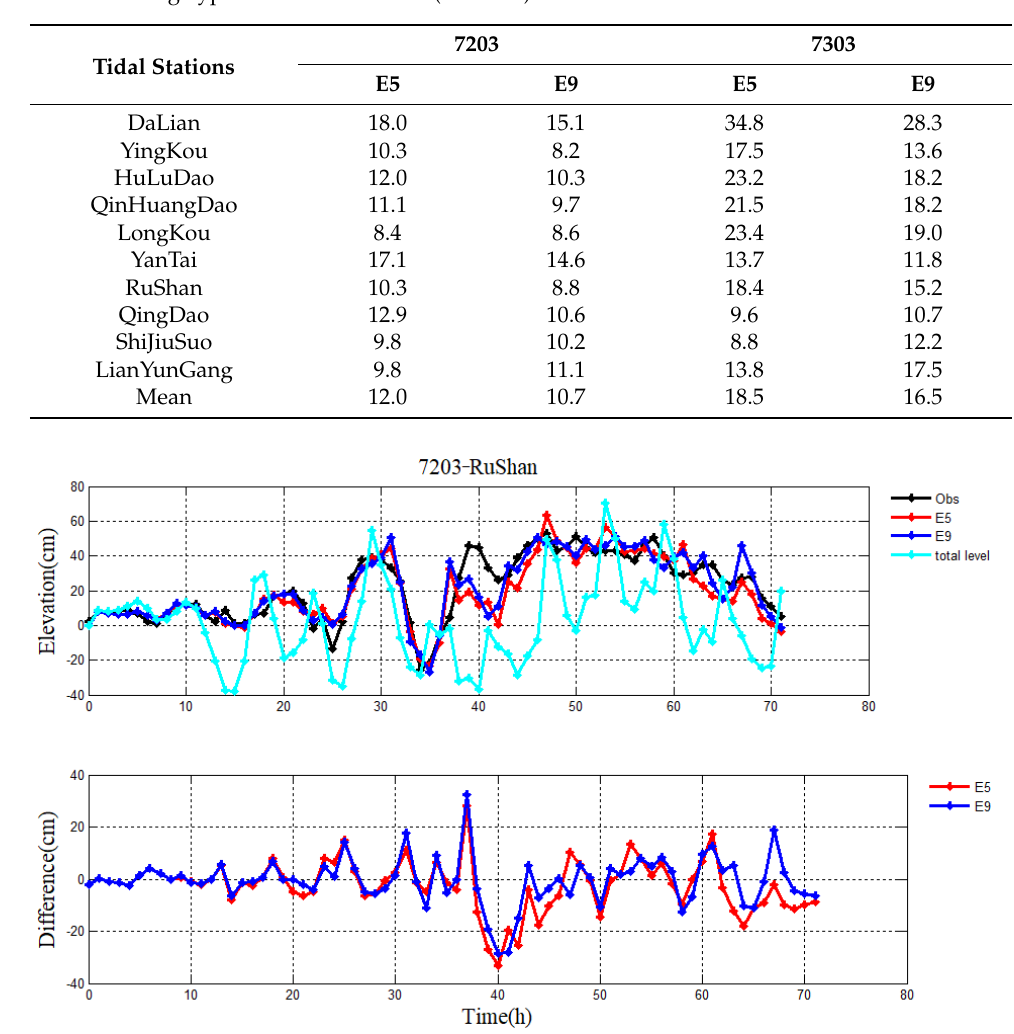
Figure 14. Storm surge levels without and with four constituents ( M 2 , S 2 , K 1 , O 1 ) in E5 and E9, respectively; observation (black line), total level of combination with the astronomical tide and storm surge (cyan line) ( top ), and their differences ( bottom ) during Typhoon 7203 at RuShan station.